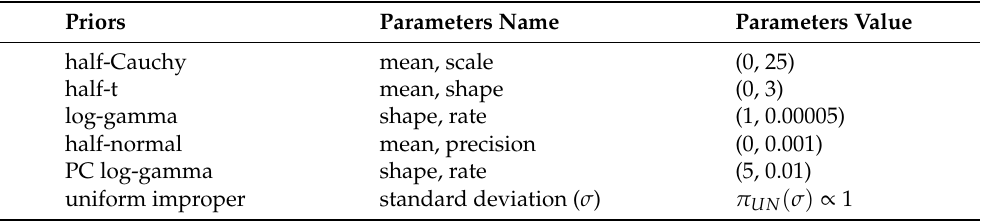
Table 1. Different Priors for the precision parameter used for model